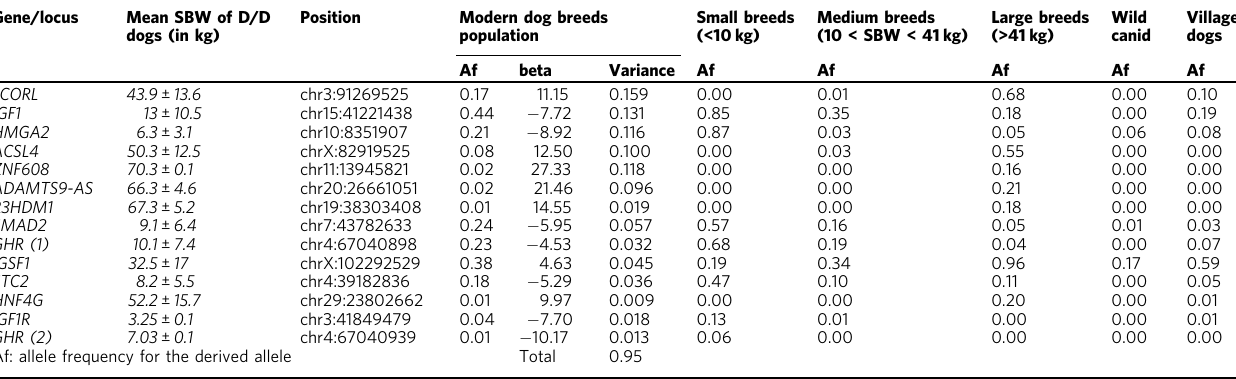
Table 4 Allele frequencies at 14 markers explain 95% of weight variation in dog population